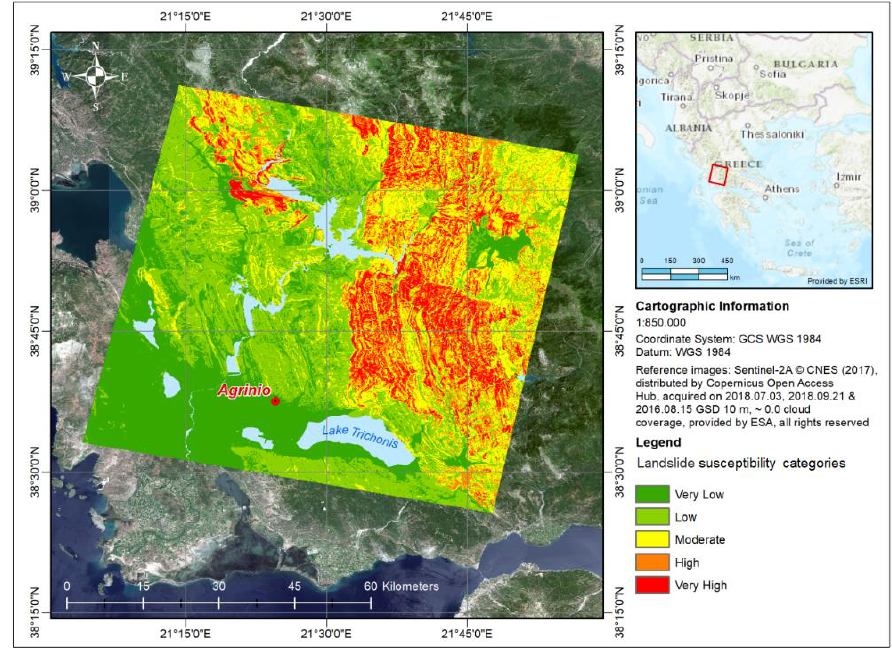
Figure 13. Landslide susceptibility map using Norwegian Geological Institute (NGI) method.